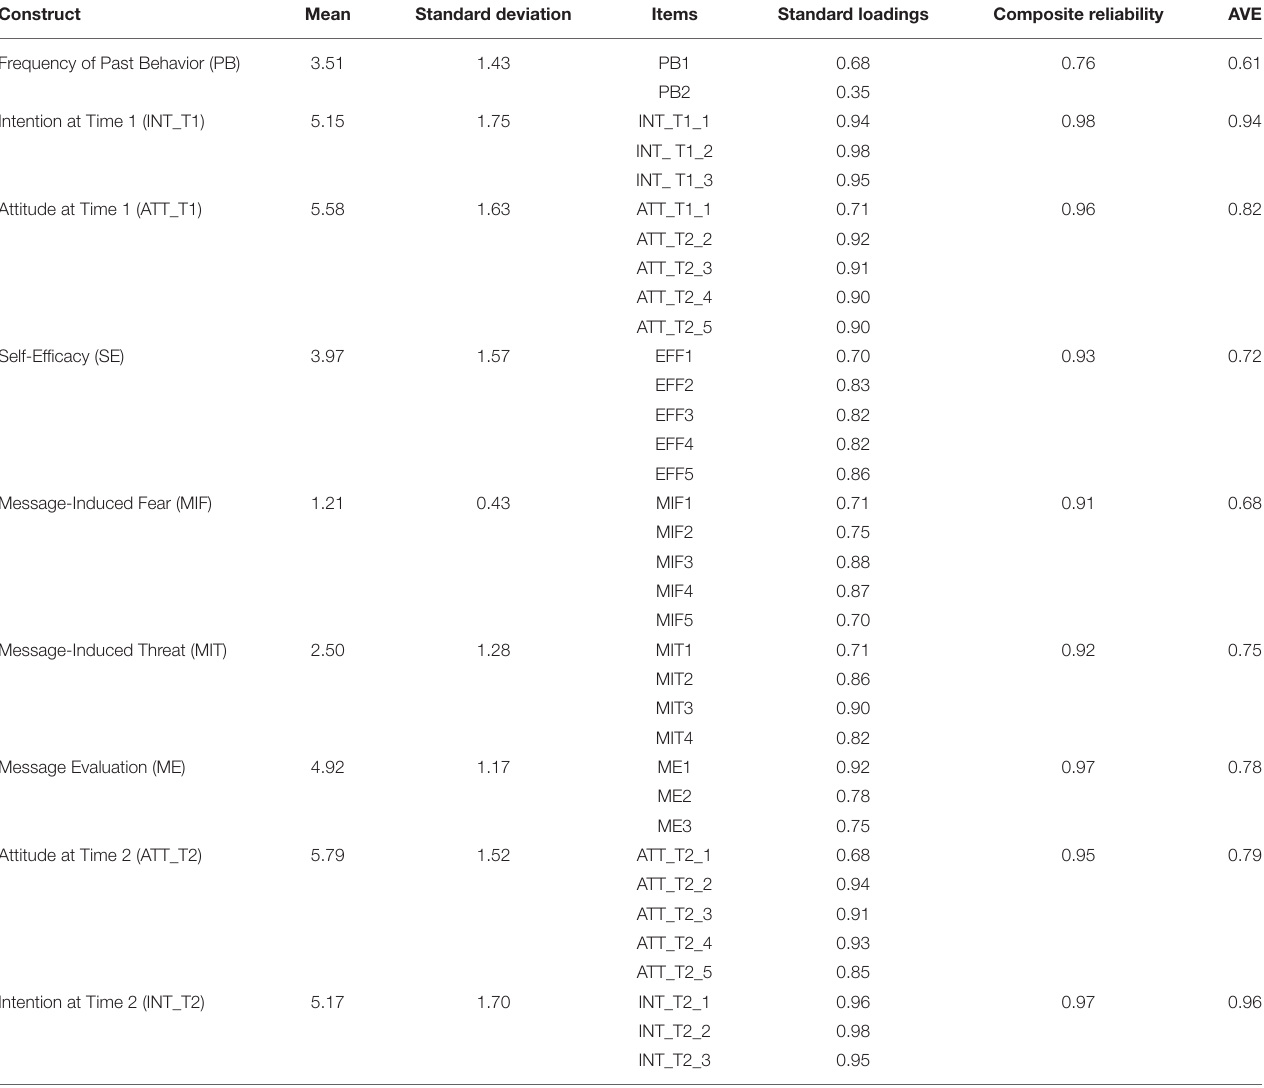
TABLE 1 | Results of the confirmatory factor analysis.